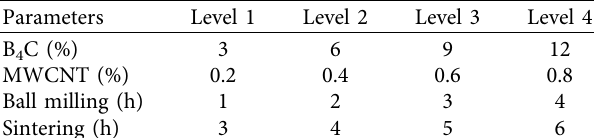
Table 2: Process parameters and their levels of the P/M process.